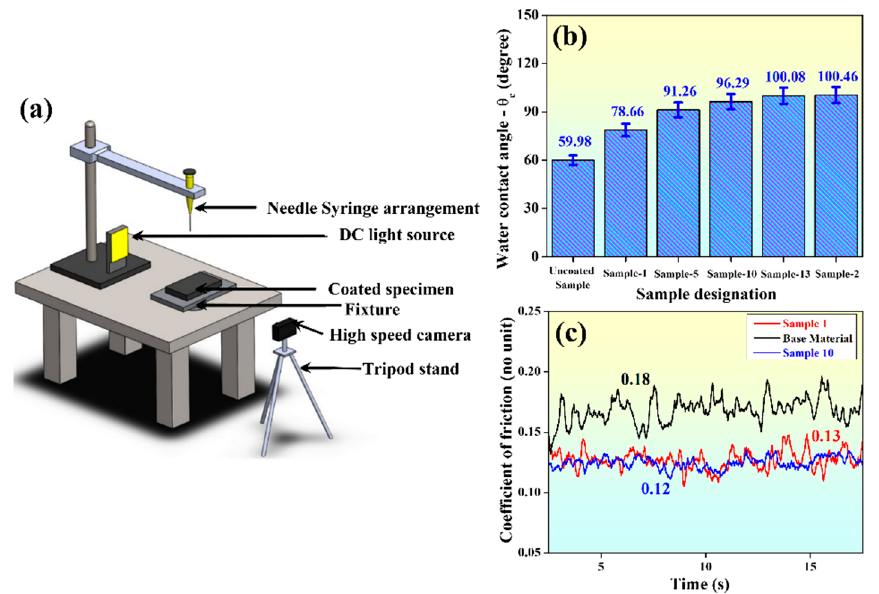
Figure 10. ( a ) In-house-built water contact angle measurement set-up [36], ( b ) water contact angles for different samples, and ( c ) variation of the coefficient of friction over time during the micro- scratch